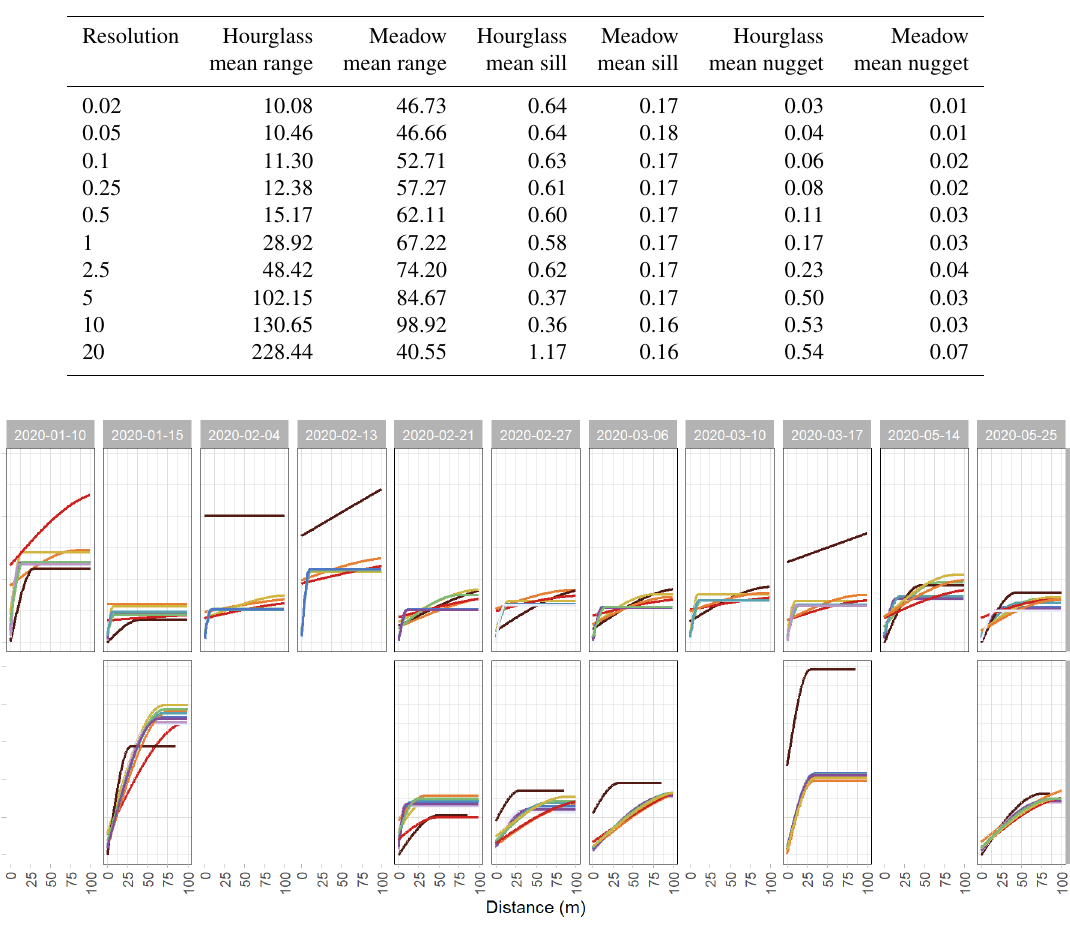
Table 2. Average spherical-fit variogram results for the Hourglass and meadow for all resolutions using the nearest-neighbor resampling method. Mean values from all analysis dates for each location at each resolution.